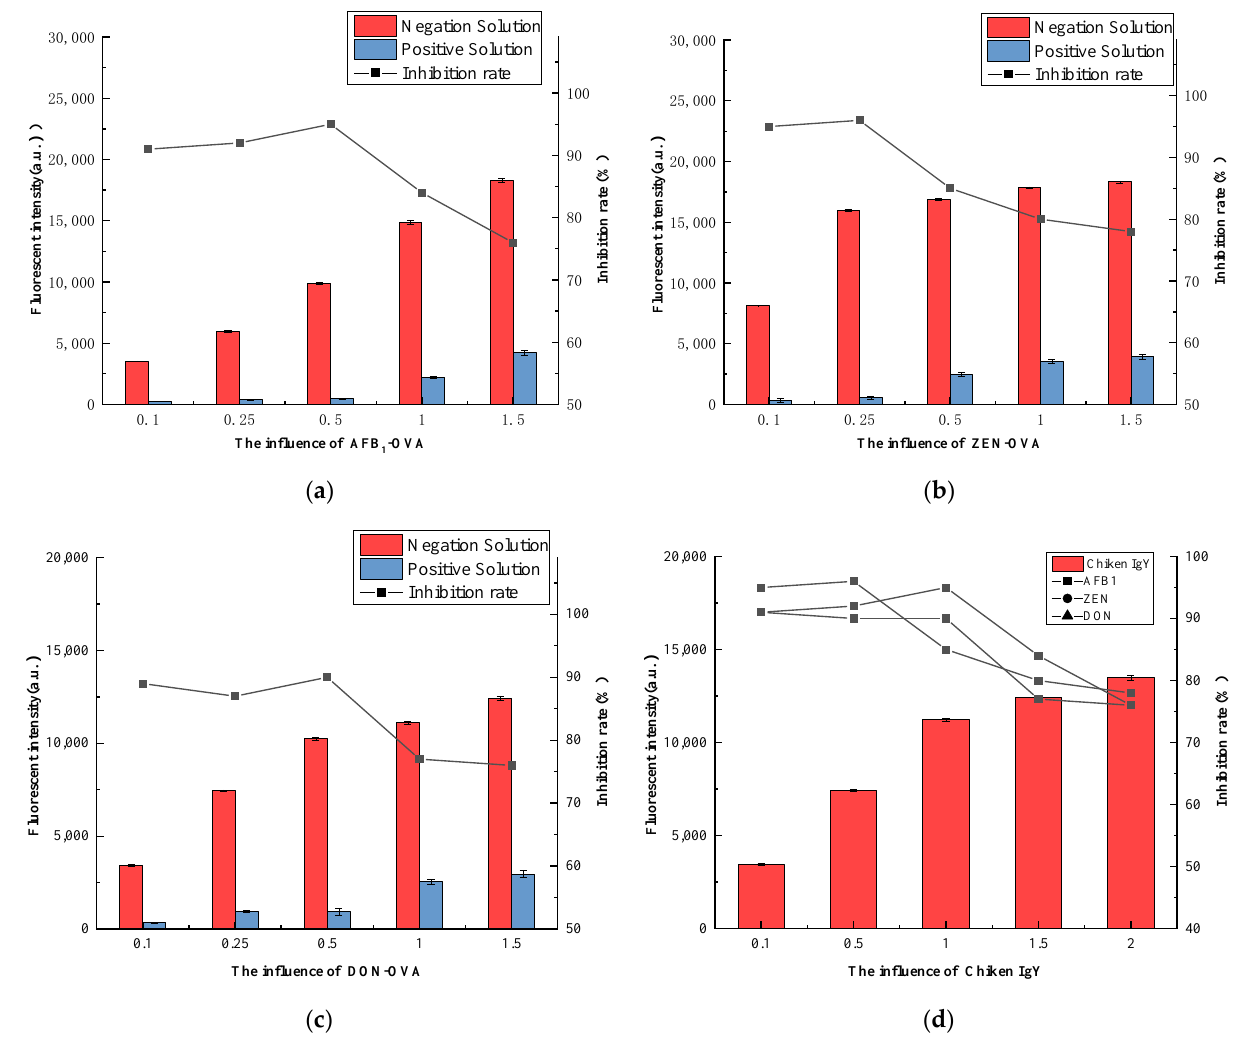
Figure 7. The coating antigens amount: ( a ) AFB 1 ; ( b ) ZEN; ( c ) DON; ( d ) Chicken IgY. 3.5. Sensitivity of the Microfluidics Using 0.01 M PBS, different concentrations of AFB1, ZEN, and DON were produced and utilized to assess the detection performance of microfluidics. The visible limit of detection (vLOD) for the eye was defined as the sample concentration at which the fluorescence disappeared from the test area. A fluorescence reader was used to measure color intensity in quantitative assays. The calculated lower limit of detection (cLOD) was defined as the concentration at 10% inhibition (IC10) of the standard curve. The linear range was defined as the concentration at the standard curve IC20 to IC80. T/T0 was defined as the ratio of the fluorescence intensity of the test area of the standard sample to the fluorescence intensity of the blank sample. After determining the T/T0 value of the unknown sample using a fluorescence reader, the concentrations of AFB1, ZEN, and DON were calculated. The results for AFB1 are shown in Figure 8a: the AFB 1 calibration curve was y = 6.30618 + (99.0788–6.30618)/(1 + (x/0.06979) 0.74859 ); the vLOD was 1.5 ng/mL; the cut-off value was 2.5 ng/mL; the cLOD was 0.003 ng/mL; and the theoretical linear range was 0.01~0.44 ng/mL. The results for Zen are shown in Figure 8b: the Zencalibration curve was y = − 19.84726 + (97.08969 − 19.84726)/(1 + (x/4.67164) 0.49902 ); the vLOD was 5.0 ng/mL; the cut-off value was 15.00 ng/mL; the cLOD was 0.05 ng/mL; and the theoretical linear range was 0.29~75.15 ng/mL. The results for DON are shown in Figure 8c: the DON calibration curve was y = − 1.56823 + (91.41032 − 1.56823)/(1 + (x/7.42751) 1.14818 ); the vLOD was 10 ng/mL; the cut-off value was 25 ng/mL; the cLOD was 1.09 ng/mL; and the theoretical linear range was 2.22~24.84 ng/mL. The actual test is shown in Figure 9.